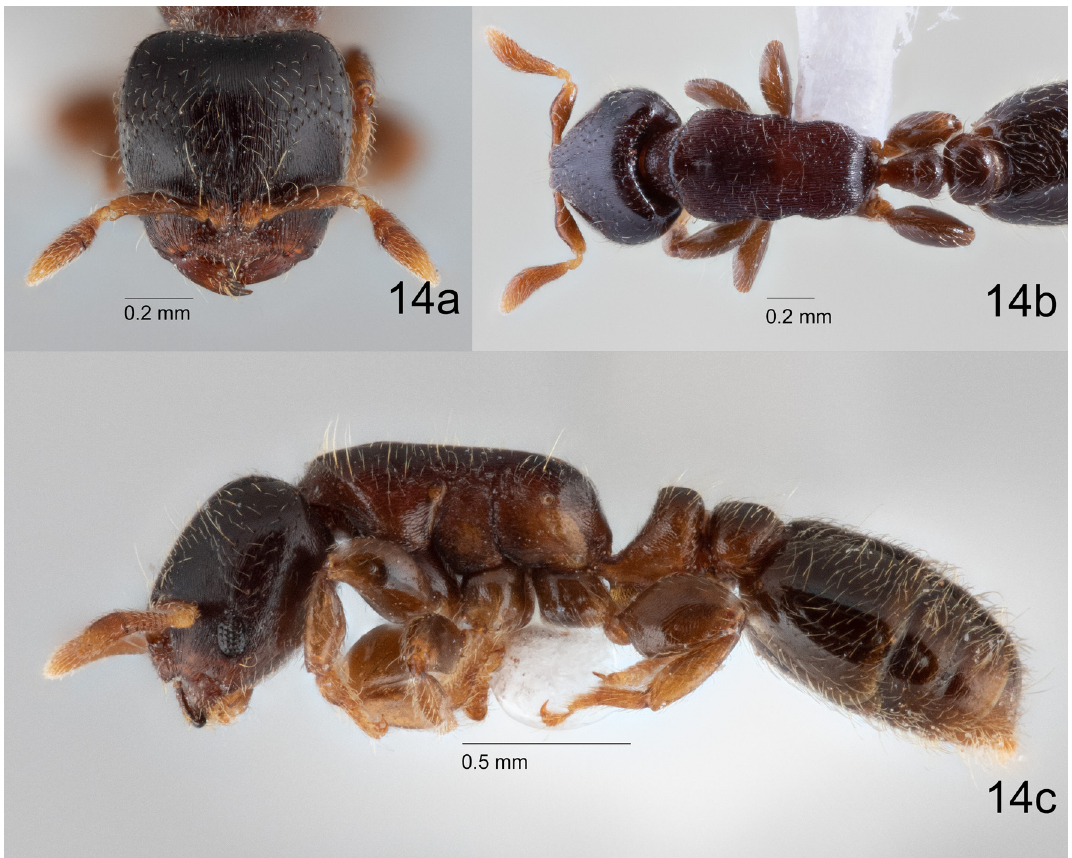
Fig. 14. Rhopalomastix robusta Wang & Jaitrong sp. nov., paratype, large worker (ZRC_ENT00013949). a . Head in full-face view. b . Body in dorsal view. c . Body in lateral